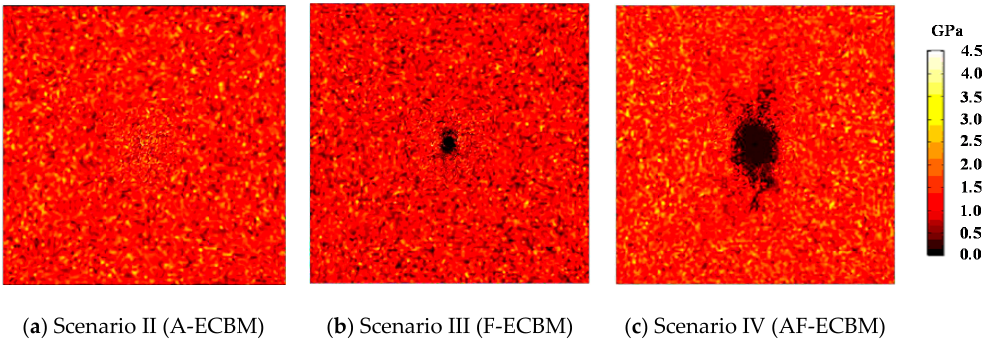
Figure 7. Elastic modulus distribution of different stimulation methods after treated 8000s.